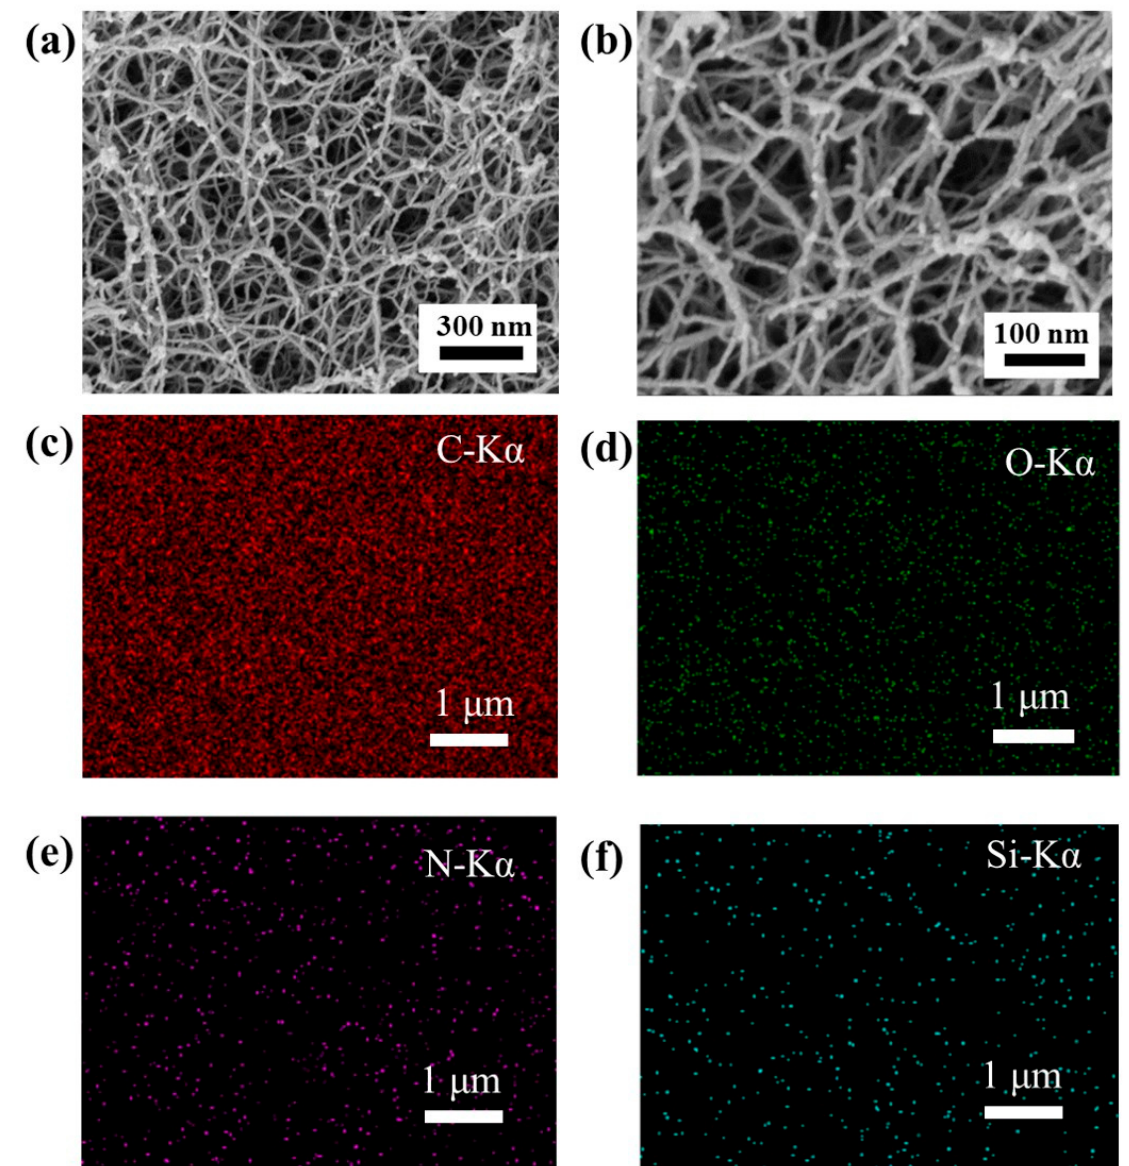
Figure 4. ( a ) SEM image of sample D-20-DMBZ; ( b ) SEM image of sample DT-20-DMBZ; ( c – f ) EDX elemental mappings of C ( c ), O ( d ), N ( e ), and Si ( f ). elemental mappings of C ( c ), O ( d ), N ( e ), and Si ( f